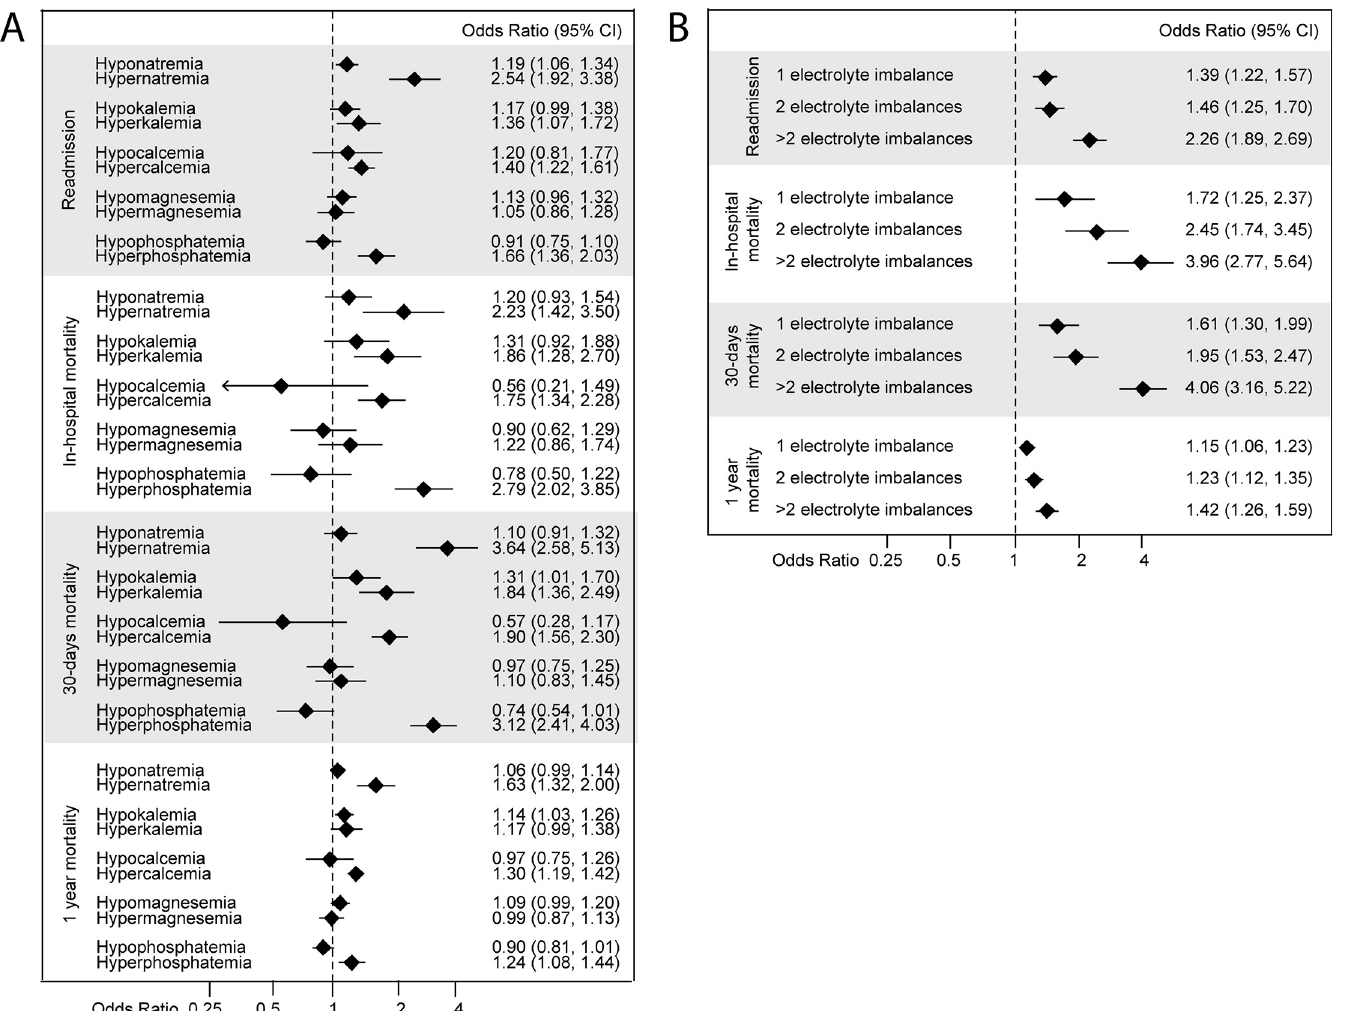
Fig 1. In-hospital, 30-days, 1-year mortality and readmission. A. Adjusted for all electrolyte imbalances, age, sex and comorbid conditions (hypertension, heart failure, atrial fibrillation/atrial flutter, chronic pulmonary disease, cancer, kidney failure, dehydration, diabetes mellitus, pneumonia, sepsis and hip fracture). B. Adjusted after number of electrolyte imbalances; 1, 2, or > 2 electrolyte imbalances.